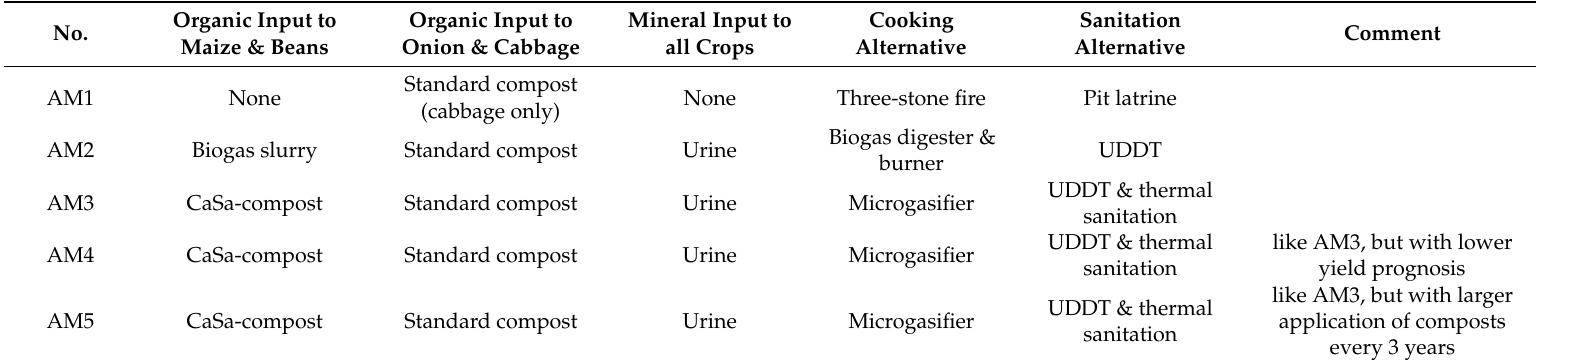
Table 1. Alternatives defined to compare different integrated plant nutrient management (IPNM) strategies (AM2–5) to the current practice (AM1) in an intercropping system in Karagwe, TZ.